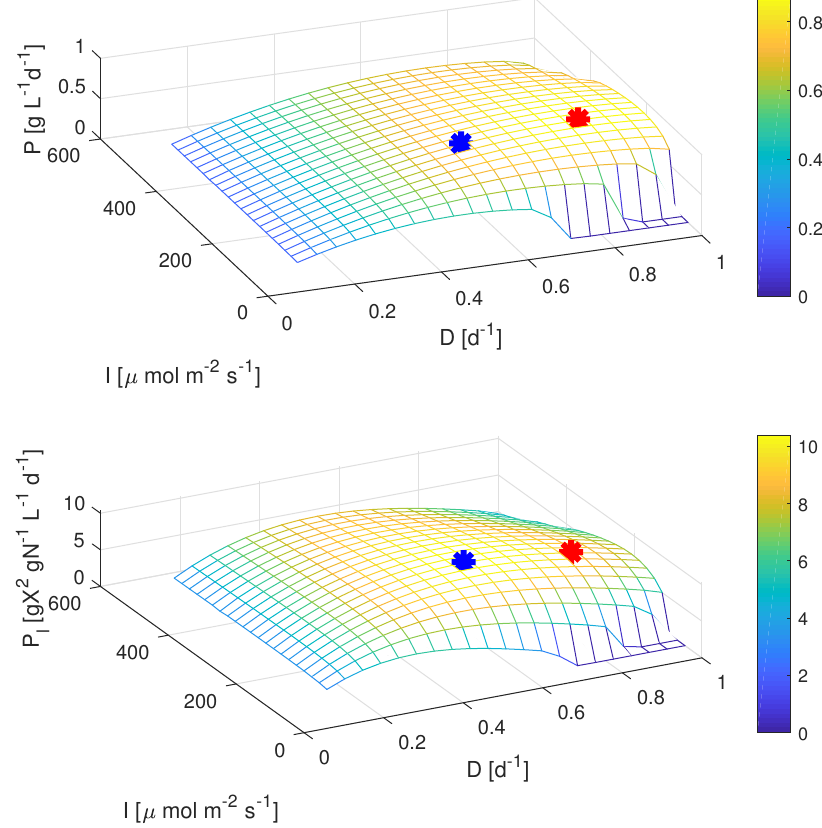
Figure 2. Steady-state productivity maps with respect to dilution rate D and incident light I . Red ’ ∗ ’: Optimal values using P (32) and Blue ’ ∗ ’: Optimal values using P l